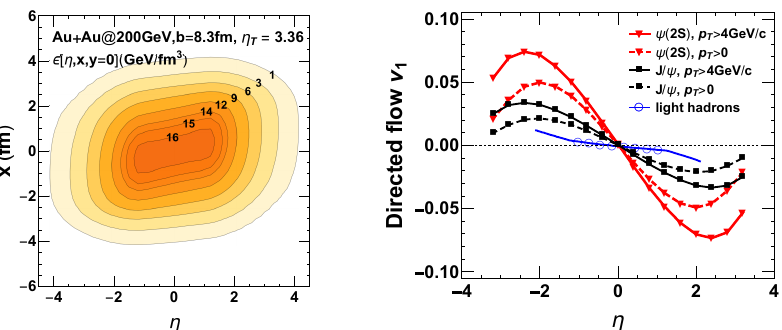
√ s NN = 200 GeV Au-Au